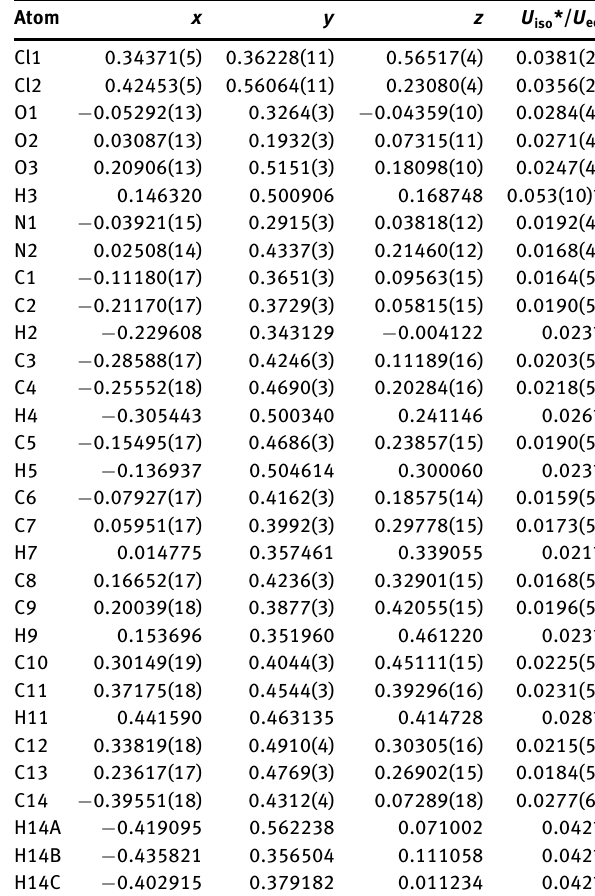
Table 2: Fractional atomic coordinates and isotropic or equivalent isotropic displacement parameters (Å 2